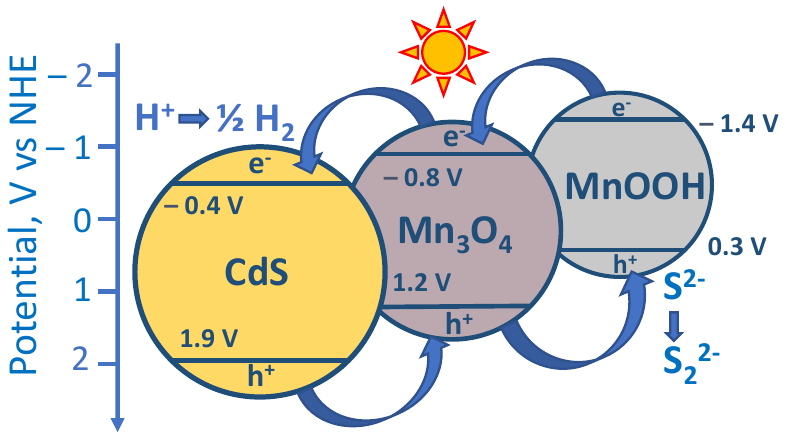
Figure 7. The proposed scheme of the heterojunctions for the photocatalyst CdS- β -Mn 3 O 4 -MnOOH. We carried out four consecutive photocatalytic runs over the samples of Mn0.4(NaOH) (CdS- β -Mn 3 O 4 -MnOOH) and Mn0.4 (Cd 0.65 Mn 0.35 S) (Figure 8a). A strong deactivation can be observed for the Cd 0.65 Mn 0.35 S photocatalyst, whose rate decreased by a factor of 2.5 in 6 h. Conversely, in the case of the composite CdS- β -Mn 3 O 4 -MnOOH sample, noticeable activation was observed, while the achieved rate of hydrogen production was 0.5 µ mol H 2 min − 1 . The XRD patterns of the samples Mn0.4(NaOH) (CdS- β -Mn 3 O 4 -MnOOH) and Mn0.4 (Cd 0.65 Mn 0.35 S) before and after four photocatalytic runs are shown in Figure 8b. For the Mn0.4(NaOH) sample, the XRD patterns are similar, whereas for the Mn0.4 sample, the single-phase solid solution Cd 0.65 Mn 0.35 S transformed into Cd 1 − x Mn x S- β - Mn 3 O 4 , leading to strong deactivation. This means that namely CdS- β -Mn 3 O 4 -MnOOH triple heterostructures are required for efficient hydrogen production. To elucidate the mechanism of activation of the Mn0.4(NaOH) sample, an XPS investigation was carried out before and after the hydrogen evolution (Table 2). According to the XPS data, sulfidation of the CdS- β -Mn 3 O 4 -MnOOH photocatalyst surface occurred, leading to an increase in photocatalytic activity. Moreover, Figure 6b represents that the activation period (around 45 min) is observed for the Mnx(NaOH) series photocatalysts, especially noticeable for the samples Mn0.4(NaOH)–Mn0.8(NaOH) , whereas for the Mnx series the period of induction is practically undistinguished. That indicates transformations leading to an increase in the activity. The evolution of hydrogen was carried out using a Na 2 S/Na 2 SO 3 aqueous solution, and light-induced sulfidation of the surface is quite possible. In addition, according to XPS data (Table 2), in the course of hydrogen production, the proportion of surface sulfide ions increases in comparison with sulfates/sulfites and oxysulfides, which can favorably affect the rate of the process. Thus, the composite photocatalyst CdS- β -Mn 3 O 4 -MnOOH is much more stable than the single-phase Cd 0.35 Mn 0.65 S photocatalyst. The highest activity was 600 mmol g − 1 h − 1 , and the maximum value of the apparent quantum efficiency reached 2.9% for the Mn0.4(NaOH) sample ( λ = 450 nm). These values are not very high in comparison to the recently published data on Cd 1 − x Mn x S-based systems [14,15,18,25,38] (Table 3). However, in this work, we used inorganic sodium sulfide for the precipitation of the sulfides. Further, no co-catalysts were deposited on the surfaces of the samples, and the activities were comparable to the data on non-modified Cd 1 − x Mn x